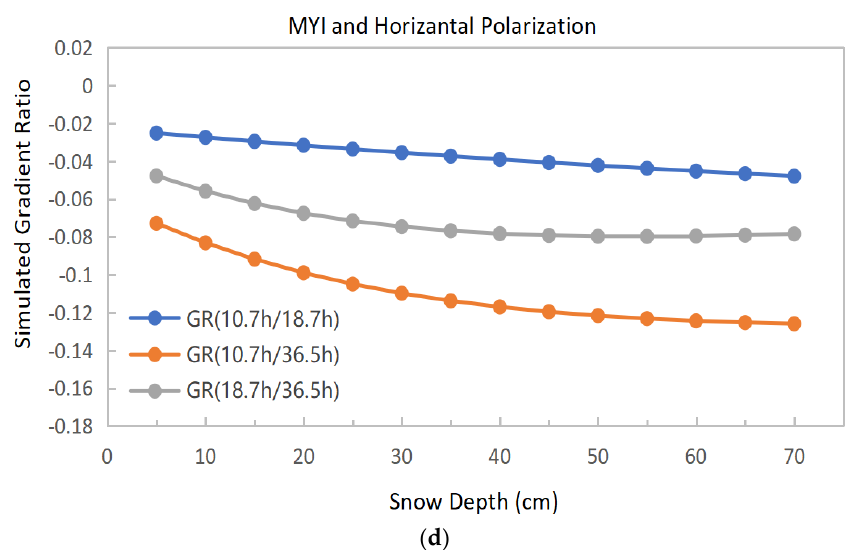
Figure 4. Change in gradient ratio (GR) with snow depth. ( a ) Vertical polarization on FYI; ( b ) horizontal polarization on FYI; ( c ) vertical polarization on MYI; ( d ) horizontal polarization on MYI.